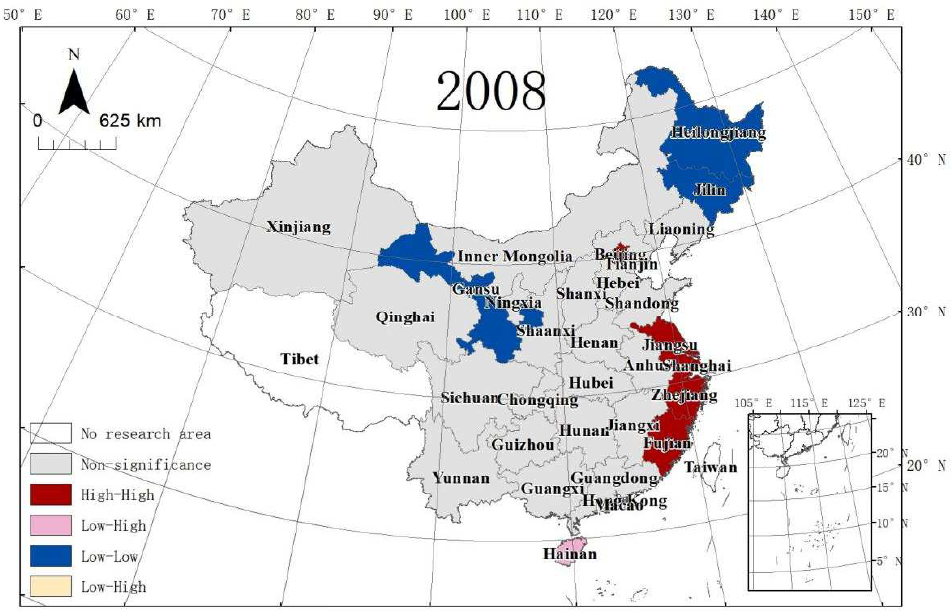
Figure 8. LISA of ULGLE in 30 provinces in 2008.